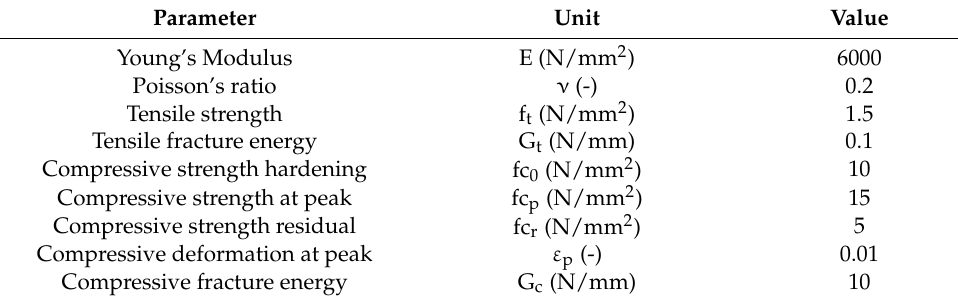
Table 1. Brick material parameters.